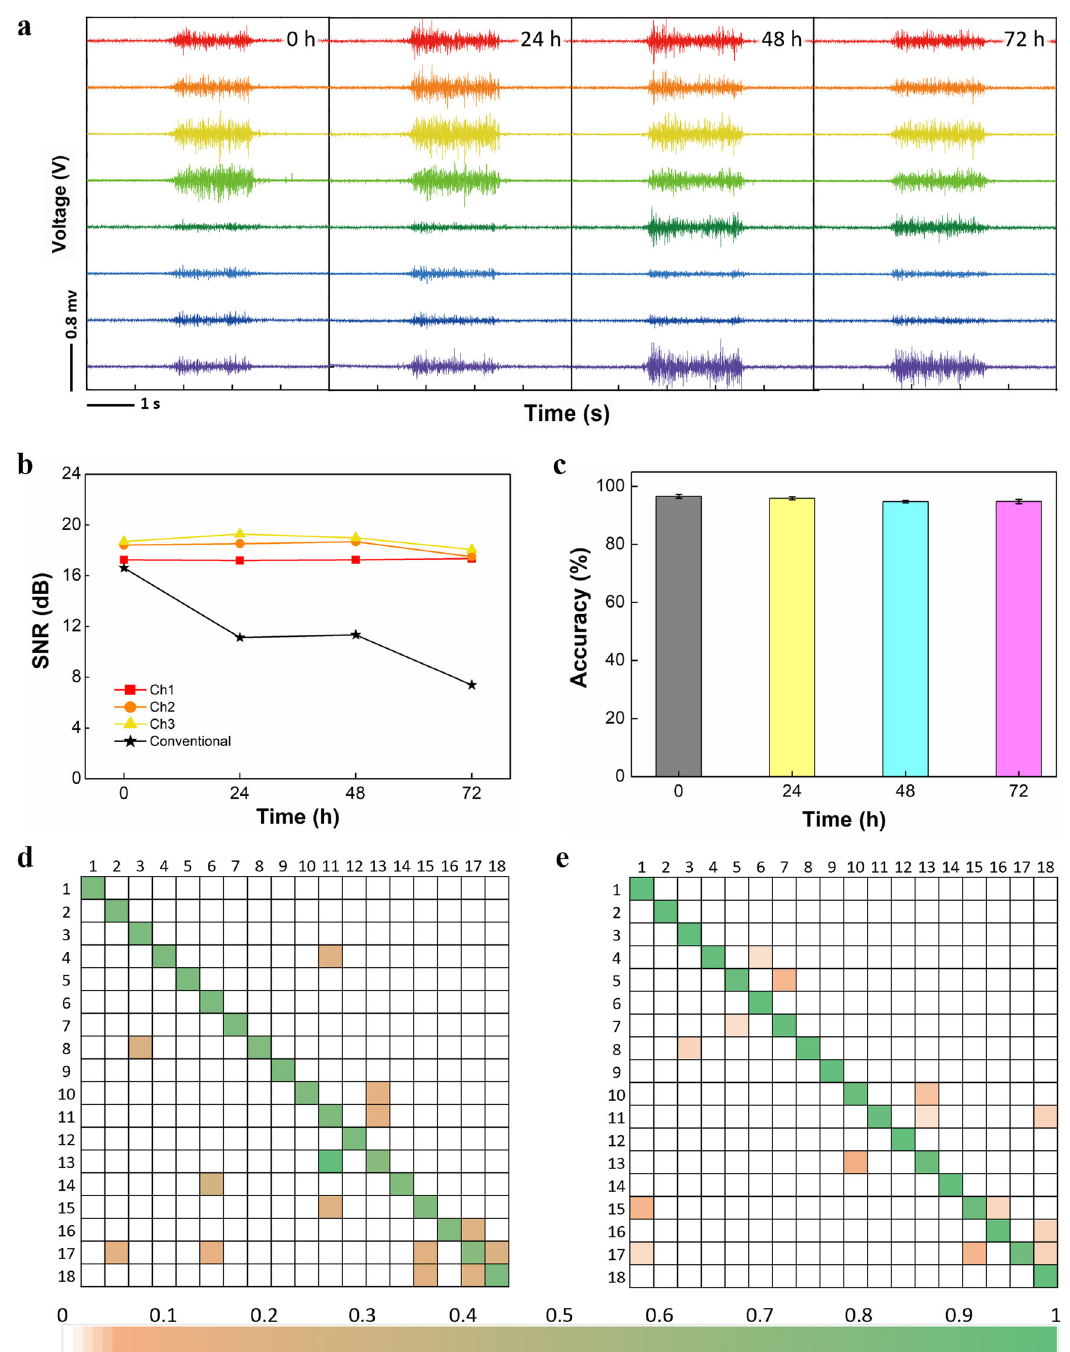
Fig. 5 Evaluation of long-term usability of the on-skin stretchable array sensor by recording the sEMG signals and graph attention network using 18 gestures. a Raw sEMG signals recorded consecutively four times every 24 h, for position 2 of the wrist-fold back gesture. b The extracted SNR for channels 1 – 3 and conventional gel electrodes; gel electrodes suffer from dehydration in contrast to stable thin metal fi lm-based KS stretchable electrodes. c Gesture recognition accuracy execution for every 24 h. Explicit representation of gesture recognition accuracy of sensor position 2 in the form of the confusion matrix executed d initially, and e after 72